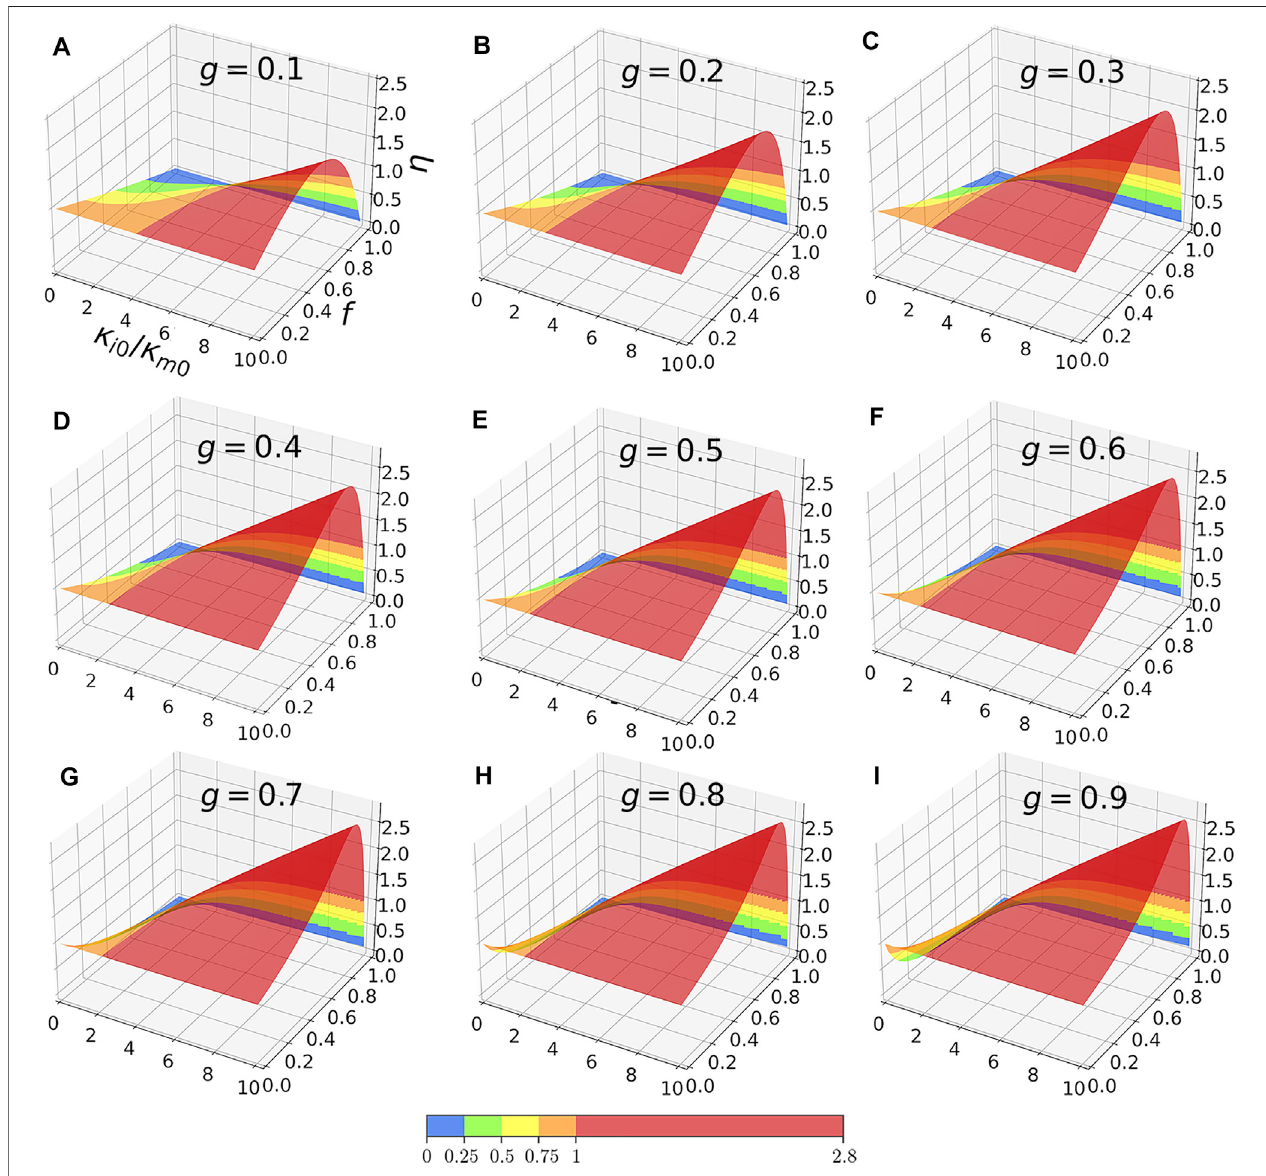
FIGURE 3 | Same as Figure 2 , but for linear inclusions and nonlinear